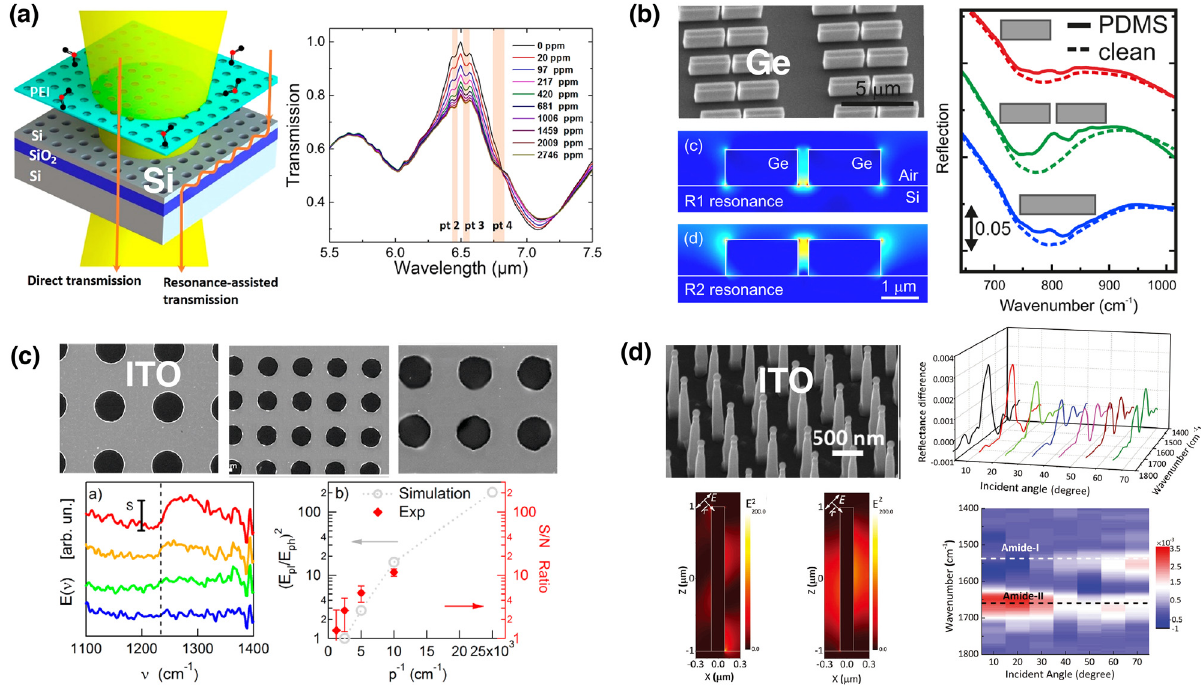
Figure 2: Dielectric nanostructure-based SEIRA structures. (a) Si photonic crystal slab: schematic illustration of the slab and its application to highly-sensitive SEIRA sensing of CO 2 gas. (b) Highly-doped germaniumnanogapantenna:SEMimage,calculatedelectric fi elddistributionattworesonantfrequencies,andSEIRAspectra.(c)Microperiodic ITO hole arrays: SEM images of arrays with various lattice periods, their SEIRA spectra and fi eld enhancements. (d) Periodic arrays of vertically alignedITOnanorods:SEMimagesandnear- fi eldintensitypro fi lesattworesonantmodes(1500cm − 1 and2500cm − 1 ).There fl ectancedifference spectra of the streptavidin molecules on ITO nanorods under different incident angles are also shown. [(a) Reproduced with permission from reference [35]. Copyright © 2018, American Chemical Society; (b) reproduced with permission from reference [44]. Copyright © 2015, American Chemical Society; (c) reproduced with permission from reference [49]. Copyright © 2018, American Chemical Society: (d) reproduced with permission from reference [46]. Copyright © 2017,